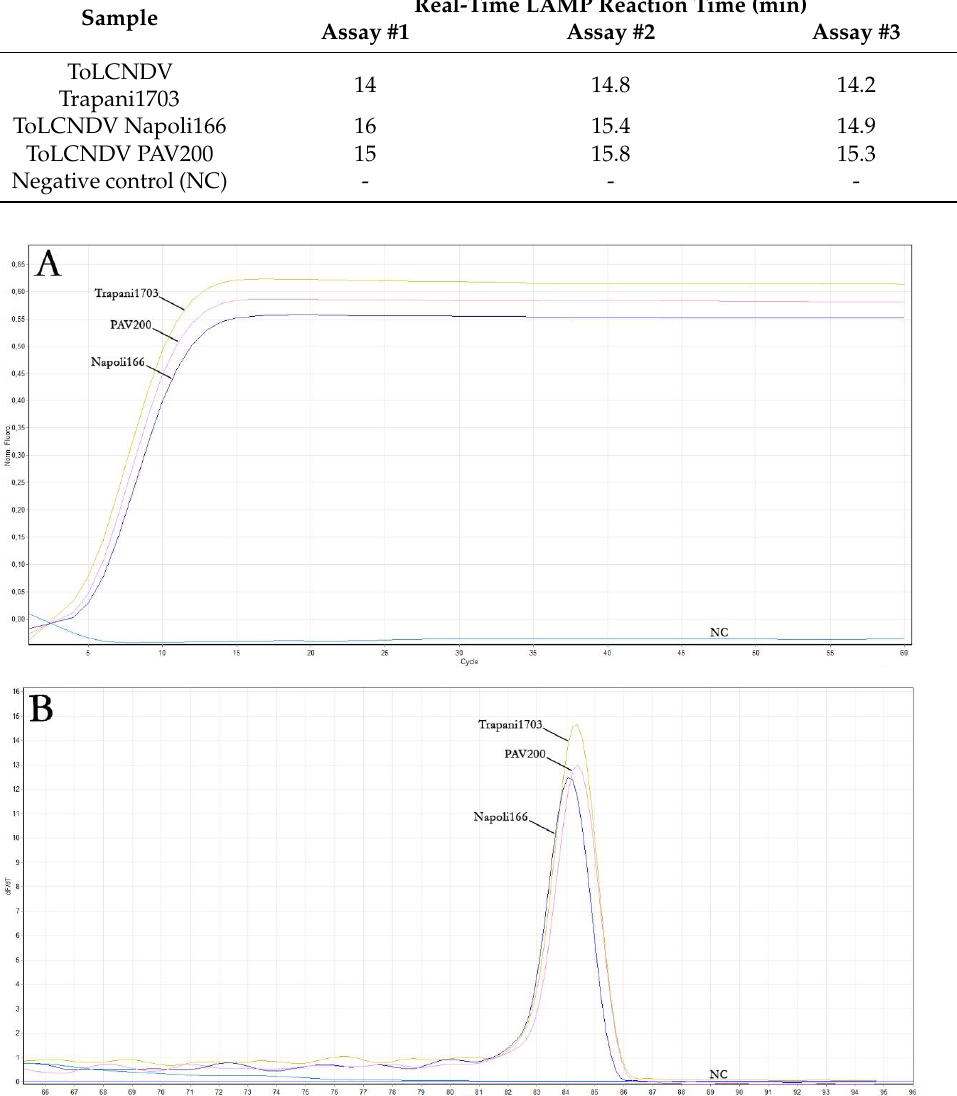
Figure 2. Results of the real-time LAMP assay for the detection of ToLCNDV. ( A ) Real-time LAMP amplification curves of the three ToLCNDV isolates. ( B ) Melting curves. NC: negative control.